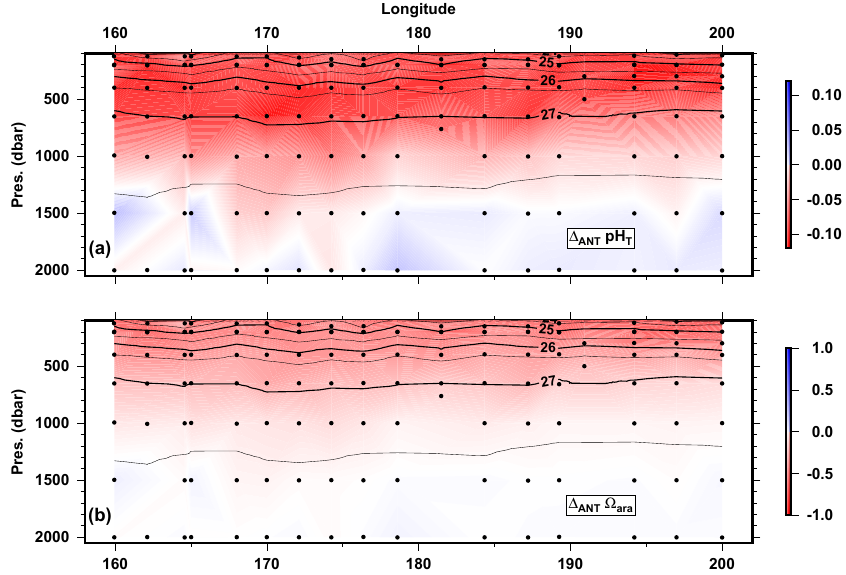
Figure 6. Longitudinal variations in (a) pH T changes and (b) (cid:127) ara changes between the pre-industrial period and the present time along the OUTPACE transect between 100 and 2000dbar depth (see text for details). Black contour lines represent the isopycnal horizons based on potential density referenced to a pressure of